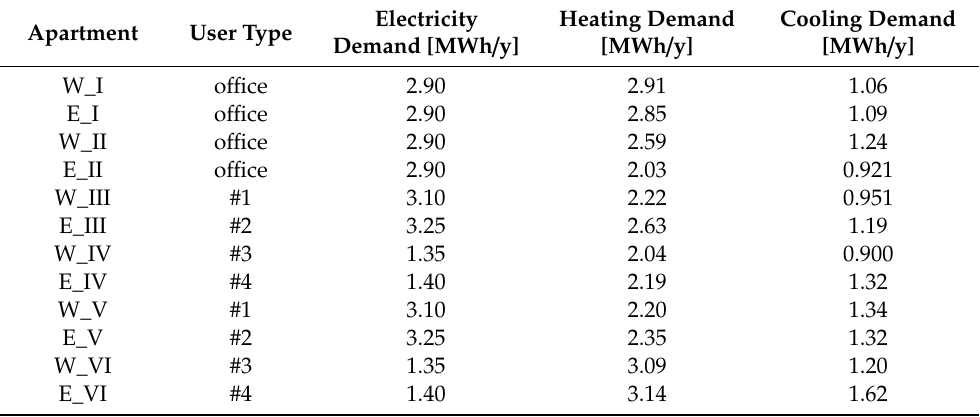
Table 1. User type and electricity, heating and cooling demand on annual basis for each flat.